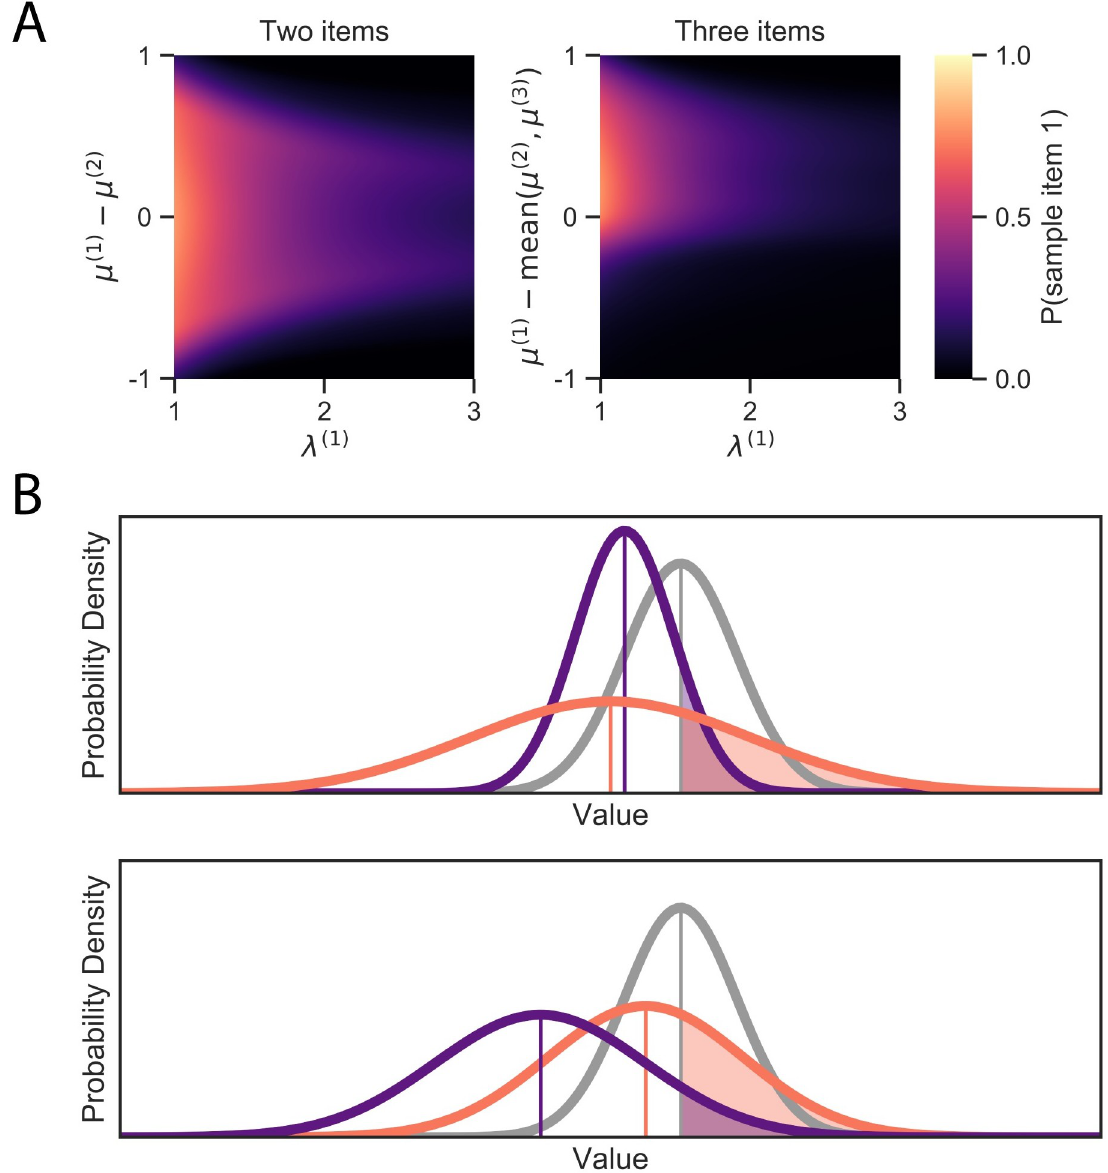
Fig 2. Optimal fixation policy. (A) Probability of fixating on item 1 as a function of the precision of its value estimate, λ (1) , and the mean of its relative value estimate, μ (1) − mean( μ (2) , μ (3) ). The heat map denotes the probability of fixating item 1 as opposed to fixating one of the other items or terminating the sampling process. (B) Illustration of the value of sampling. Each panel shows a belief state for trinary choice. The curves depict the estimated beliefs for each item’s value, and the shaded regions show the probability that the item’s true value is higher than the current best value estimate. This probability correlates strongly with the value of sampling the item because sampling is only valuable if it changes the choice (the full value of sampling additionally depends on the size of the potential gain in value, as well as the cost of future samples and the possibility of sampling other items). In each case, it is more valuable to sample the orange item than the purple item because either (top) its value is more uncertain, or (bottom) its value is closer to the leading